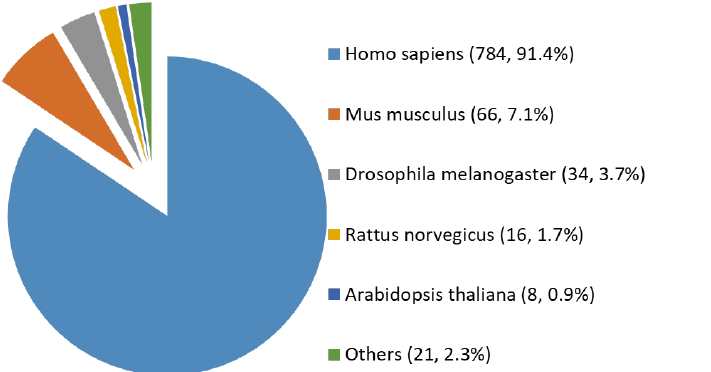
Figure 3. Species distribution of 929 high-stringency interacting proteins of OGT and orthologues. Other interactor proteins include seven from Influenza A virus strains, three from Bacillus anthracis , three from Campylobacter jejuni subsp. jejuni serotype O:2 (strain ATCC 700819/NCTC 11168), two from Caenorhabditis elegans , two from Severe acute respiratory syndrome coronavirus 2 (2019-nCoV) (SARS-CoV-2), one from Human cytomegalovirus (strain Merlin) (HHV-5) (Human herpesvirus 5), one from Oryctolagus cuniculus , one from Francisella tularensis subsp. tularensis (strain SCHU S4/Schu 4), and one from Sus scrofa (pig).